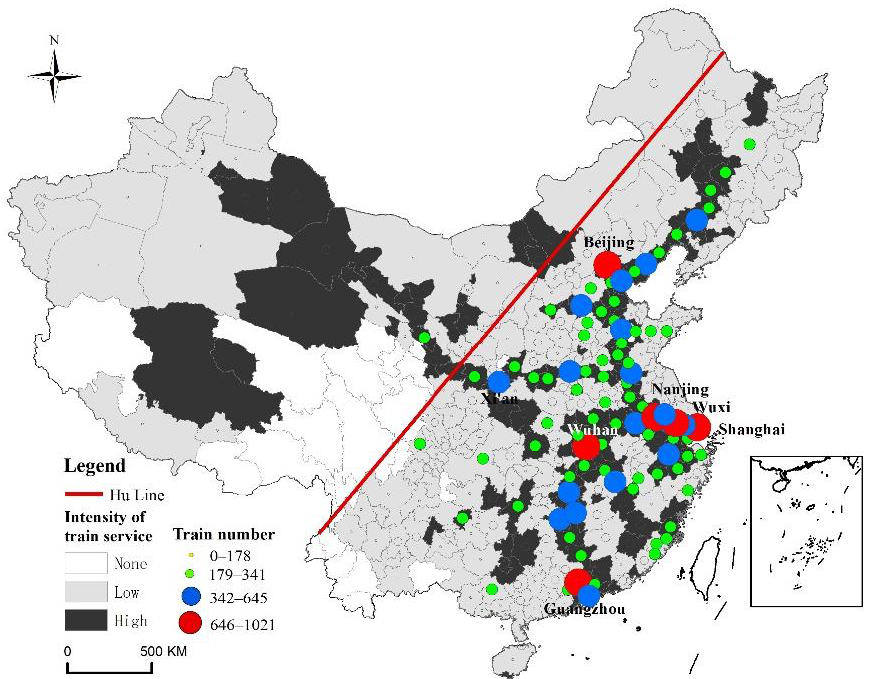
Figure 6. Distribution of train service intensity.